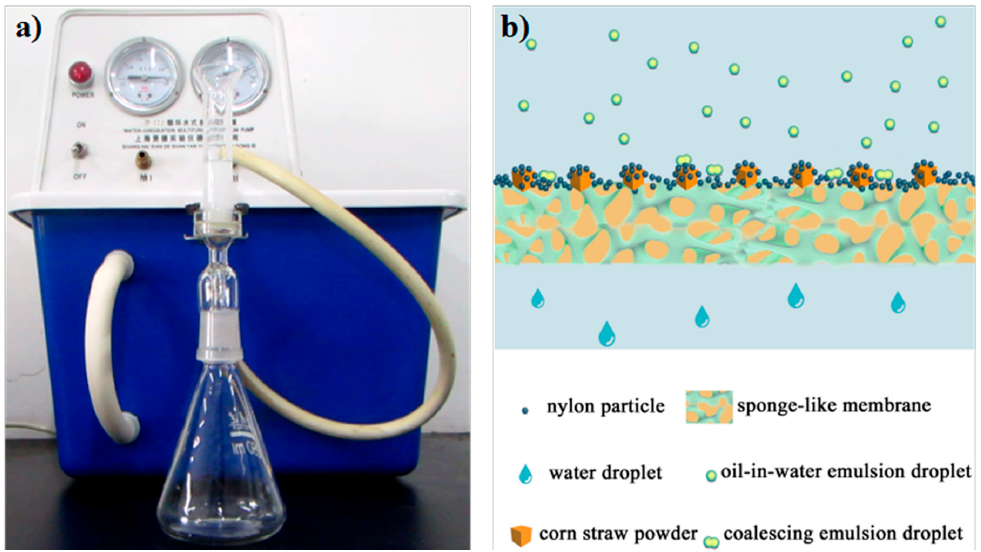
Figure 5. Schematic of the demulsification process of the emulsion on the CSPNM.